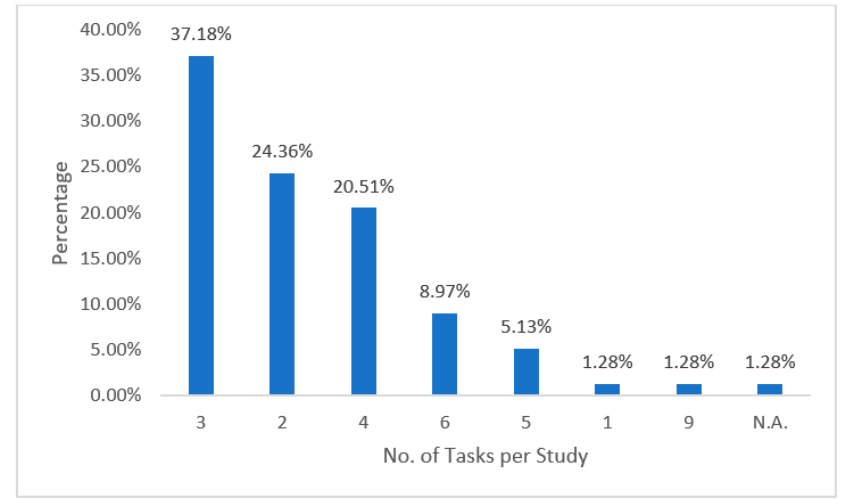
Figure 8. Tasks per study.